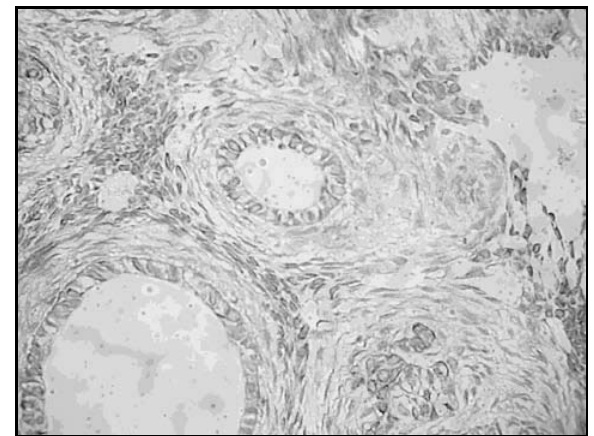
Figura 3 – Tumor odontogênico adenomatóide: positividade para CK 14 nas células ductais e fusiformes (SABC, 200x)